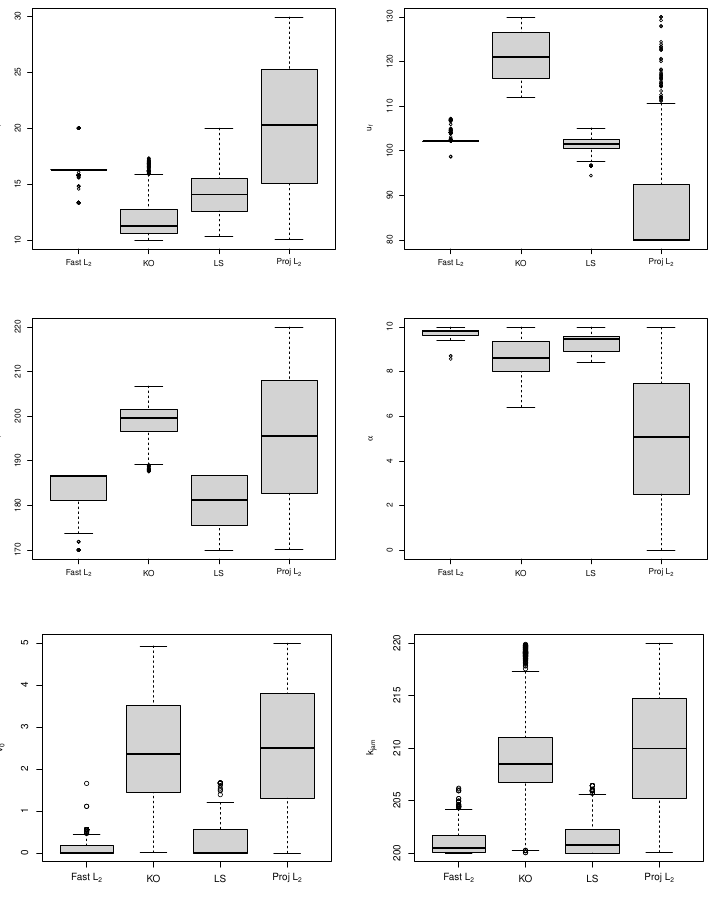
Figure 4. Box plots for four calibration methods in case